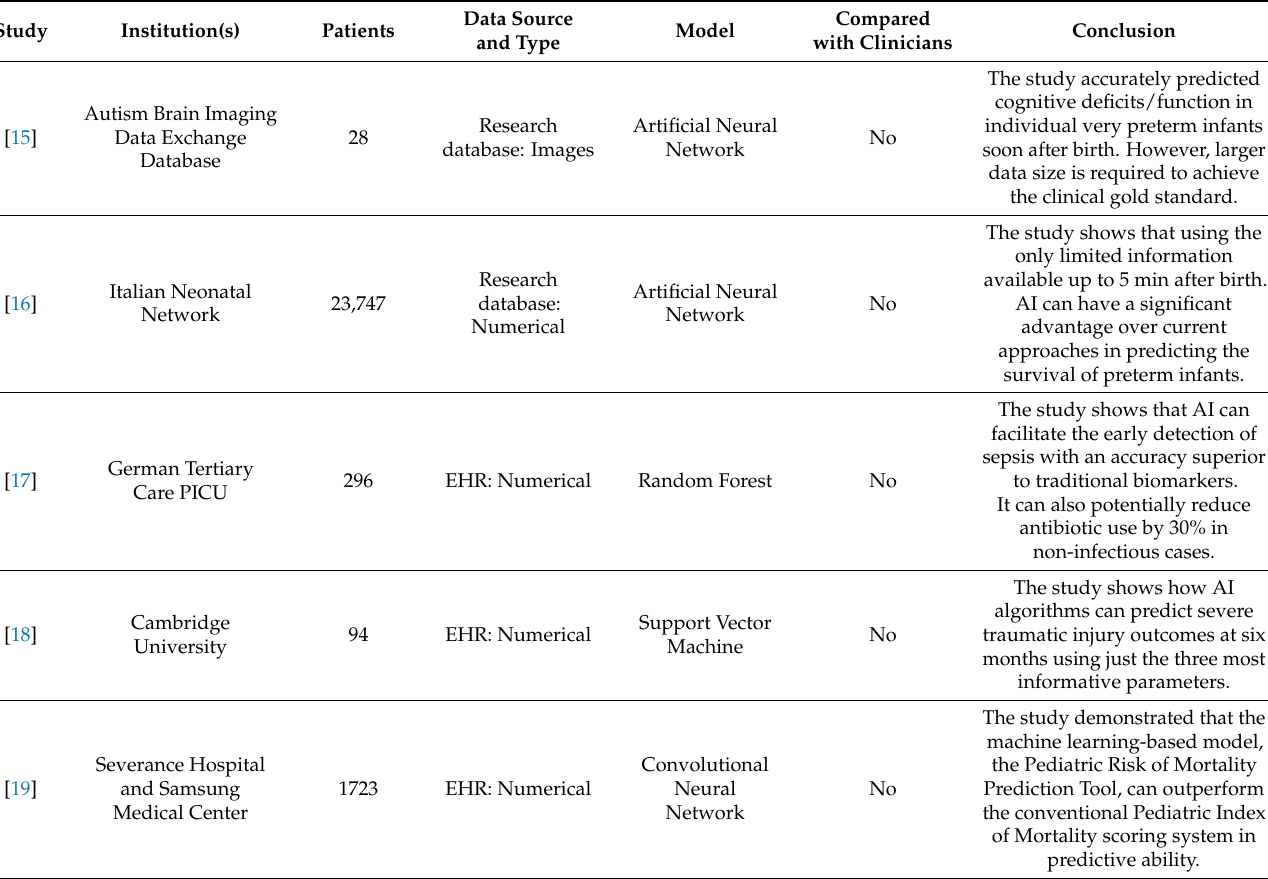
Table 1. State of the art: Artificial Intelligence in PICU and NICU (not an exhaustive